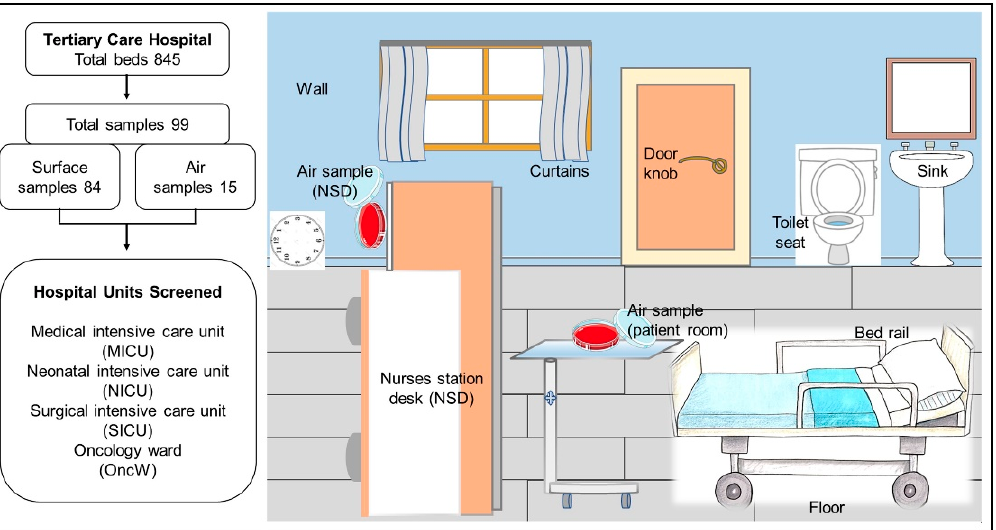
Figure 6. Overview of the sampling sites. The diagram shows the various surface sites from the hospital units that were sampled.